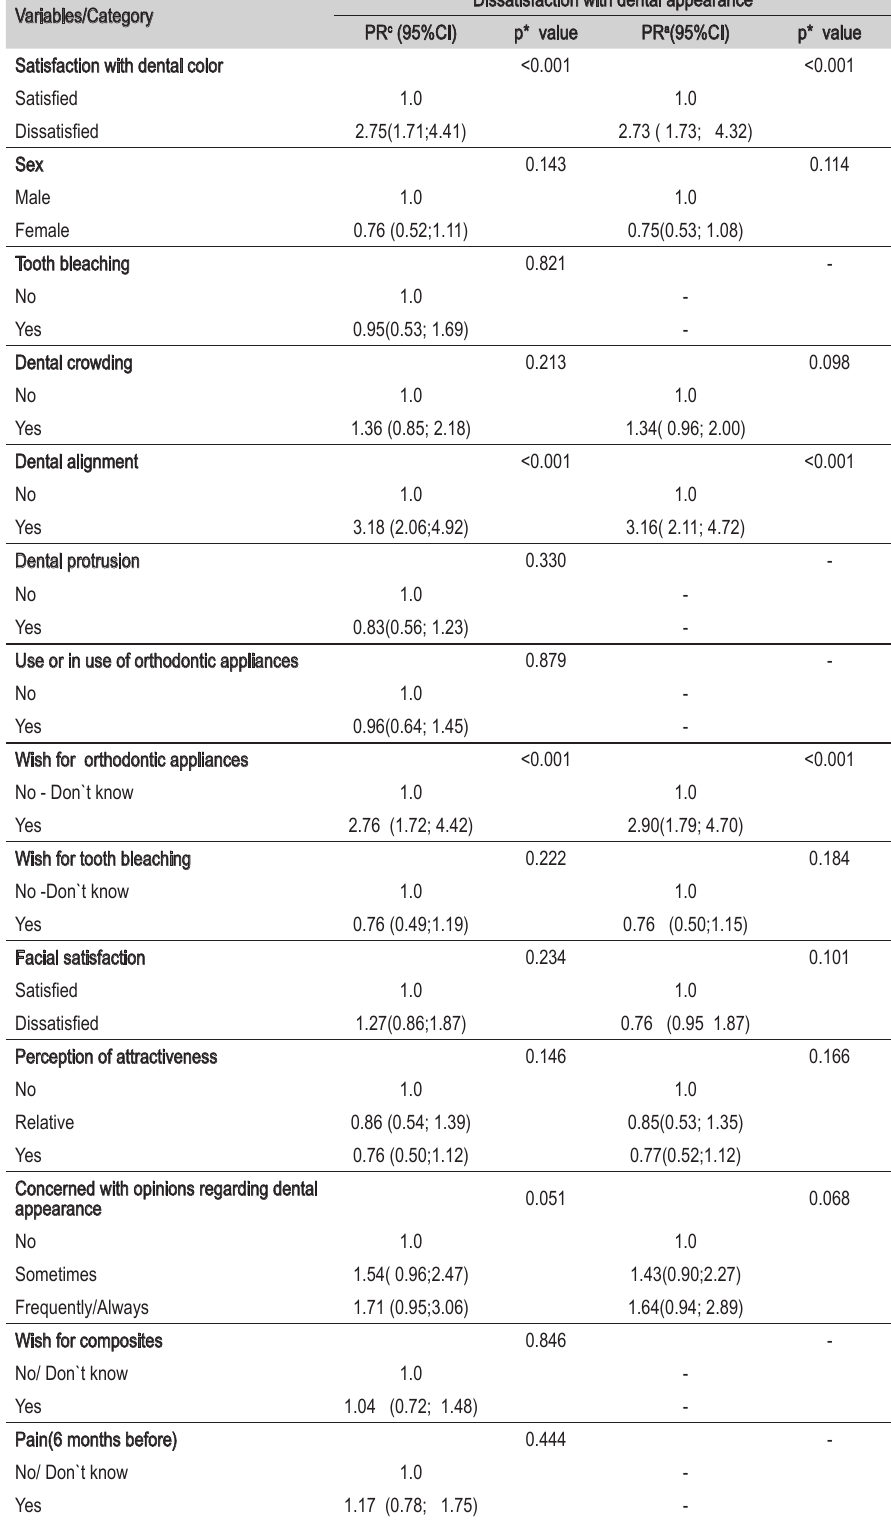
Table 3 - Crude (c) and adjusted (a) Prevalence Ratios (PR) for dissatisfaction with dental appearance in schoolchildren, according to independent variables. Pelotas, RS, Brazil.